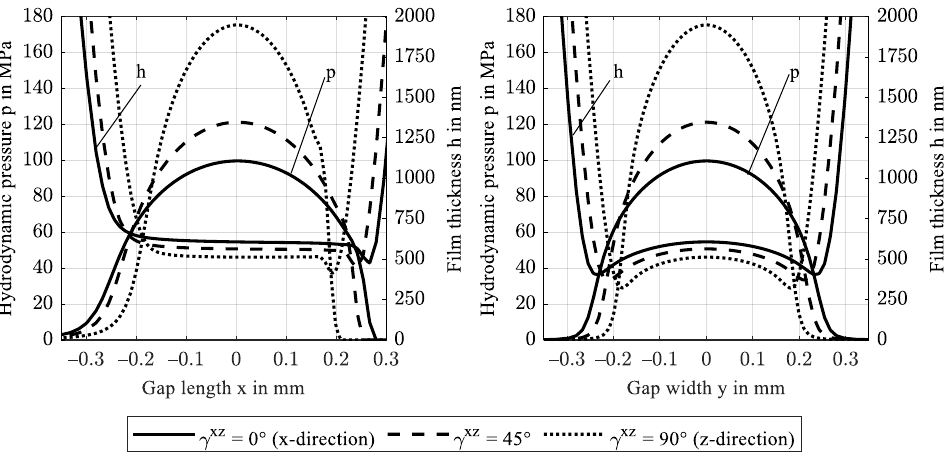
Figure A1. Hydrodynamic pressure p and film thickness profiles h along the gap length x at y = 0 ( left ) and along the gap width y at x = 0 ( right ) for rotation 𝛾 𝑥𝑧 of fiber orientation from x- to z-direction.